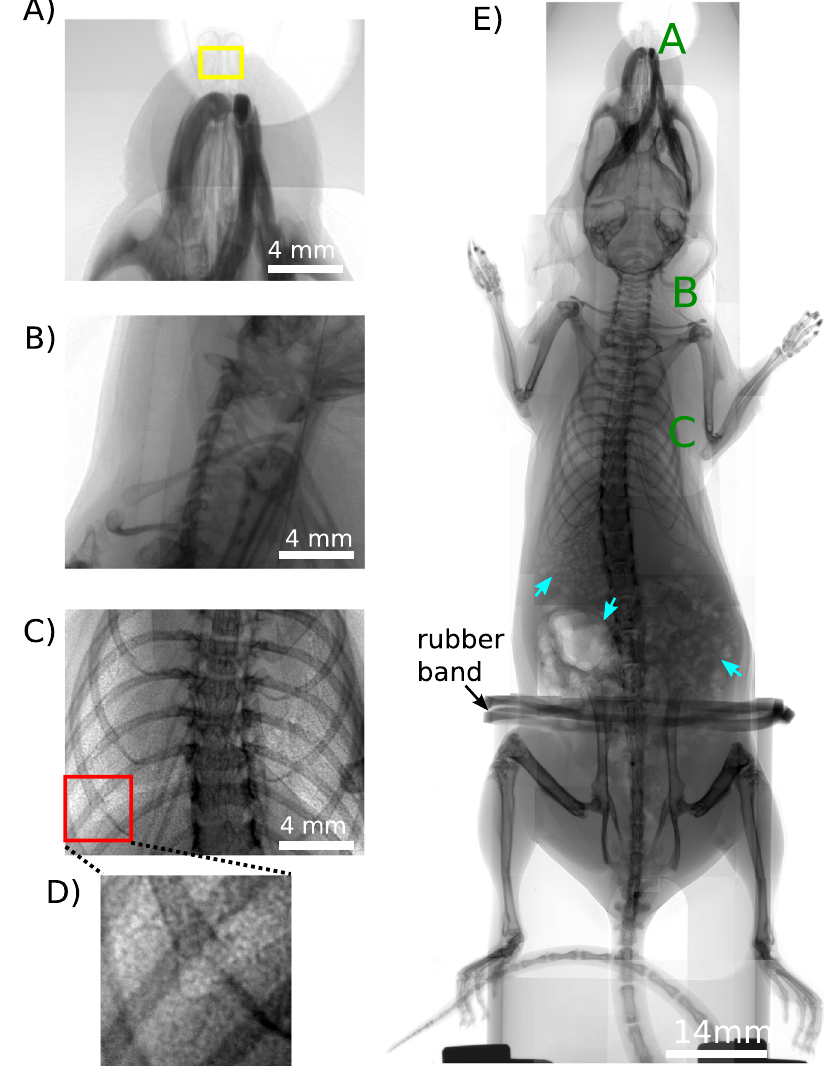
( B ) Trachea region (for A and B detector pixel size = 6.5 μ m, exposure time = 1 s), ( C ) Lung (detector pixel size = 13 μ m, exposure time = 1 s), ( D ) is a magnification of the red box in ( C ) and shows the speckle pattern which results from the air sacs in the lungs, the alveoli. ( E ) Overview scan of the ex-vivo mouse imaged with propagation-based X-ray phase-contrast, composite image using 1 m propagation and 10 second exposure times (detector pixel size = 6.5 μ m). The green letters A, B, C indicates the regions where the images shown in panels A–C were taken. The mouse was fixed with a rubber band. In the stomach gas bubbles are visible (highlighted with blue